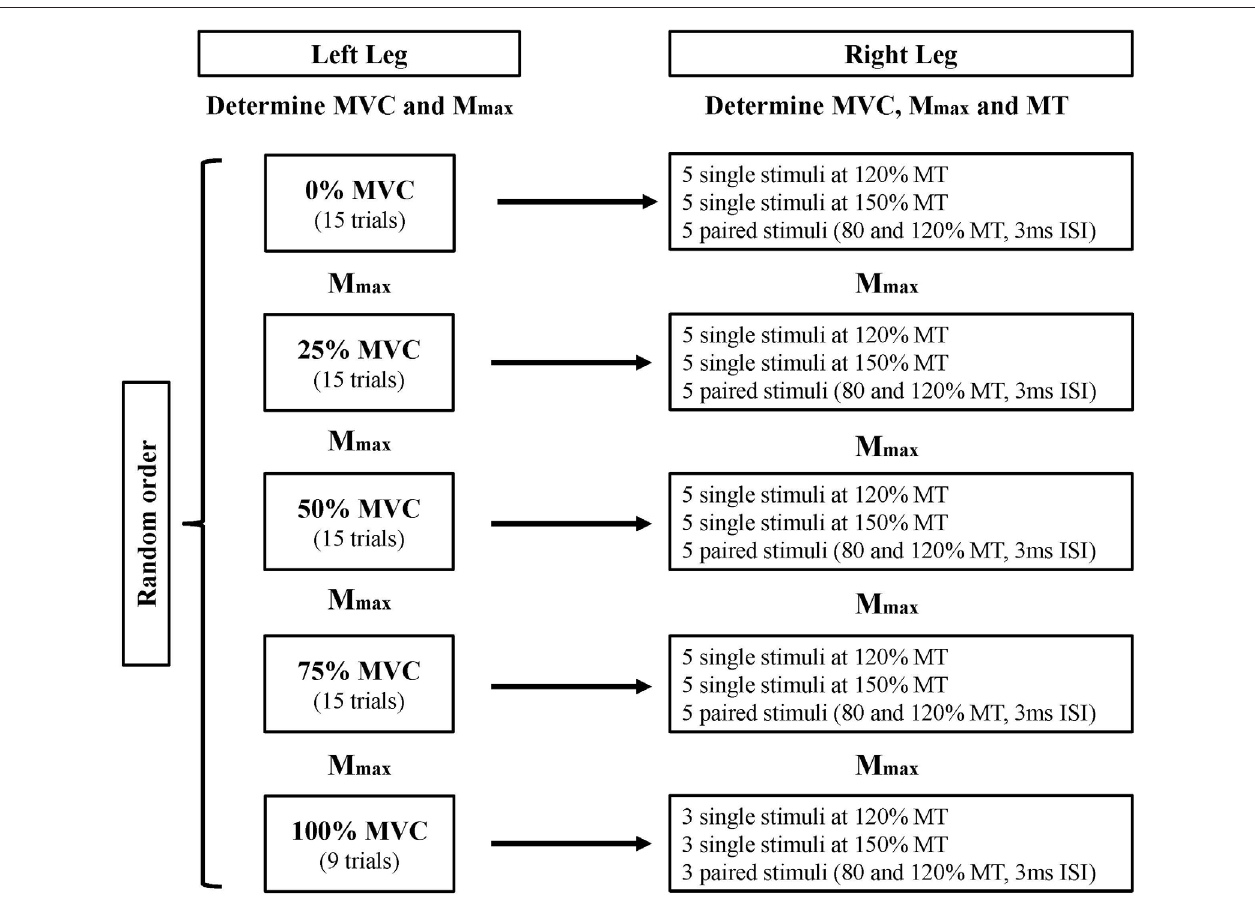
FIGURE 1 | Experiment design. The left quadriceps contracts at five different contraction intensities (0, 25, 50, 75 and 100% MVC) while corticomotor responses of the right rectus femoris (RF) were measured. The measurement order of left quadriceps contraction intensity and transcranial magnetic stimulation (TMS) stimuli intensity were randomized. The entire protocol was first completed for Experiment 1 (right leg resting), then repeated for Experiment 2 (right leg extended). MVC, maximal voluntary contraction; M max , maximal compound wave; MT, motor threshold; ISI, interstimulus interval.